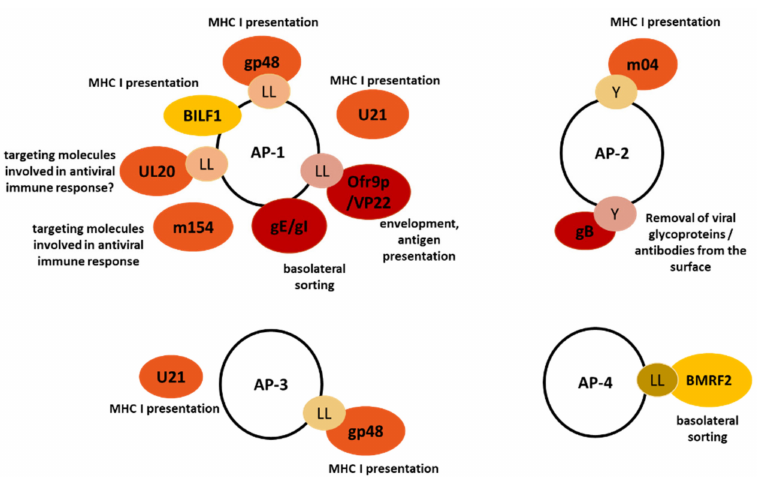
Figure 2. Herpesvirus proteins that have been found to interact with or interfere with AP complexes are presented. α -herpesvirus proteins are shown in red, β -herpesvirus in orange, and γ -herpesvirus in yellow. The function affected by herpesvirus proteins and the motif, if known, are